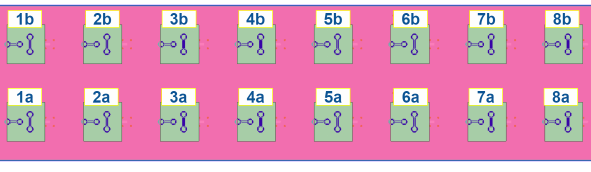
FIGURE 5: Truncated view of the 2X20 array The gain patterns of the 2X20 element phased array an- tenna for H and V polarizations at different scan angles ( θ = 0 o , θ = 30 o and θ = 55 o ) are given in Figures 6a